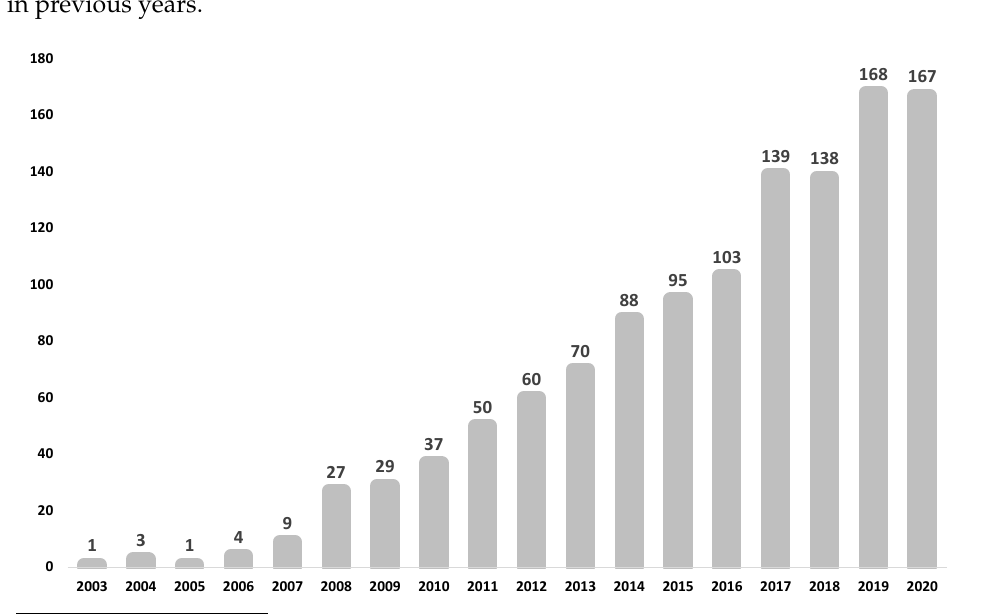
Figure 1. Number of papers published by year.